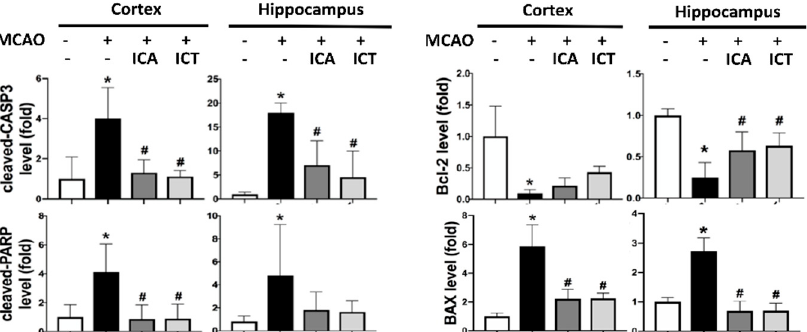
Figure 4. Both ICA and ICT treatment reduced the levels of protein expression of apoptotic markers in the left cerebral hemisphere of mice with acute cerebral ischemia–reperfusion. The levels of protein expression of apoptotic markers (cleaved caspase-3, cleaved PARP, Bcl-2, and Bax) in the hippocampus and cortex areas were determined by Western blot. The quantification of protein expression was determined by densitometry. Data are presented as mean ± SD ( n ≥ 4). * p < 0.05 compared to sham group; # p < 0.05 compared to MCAO group.